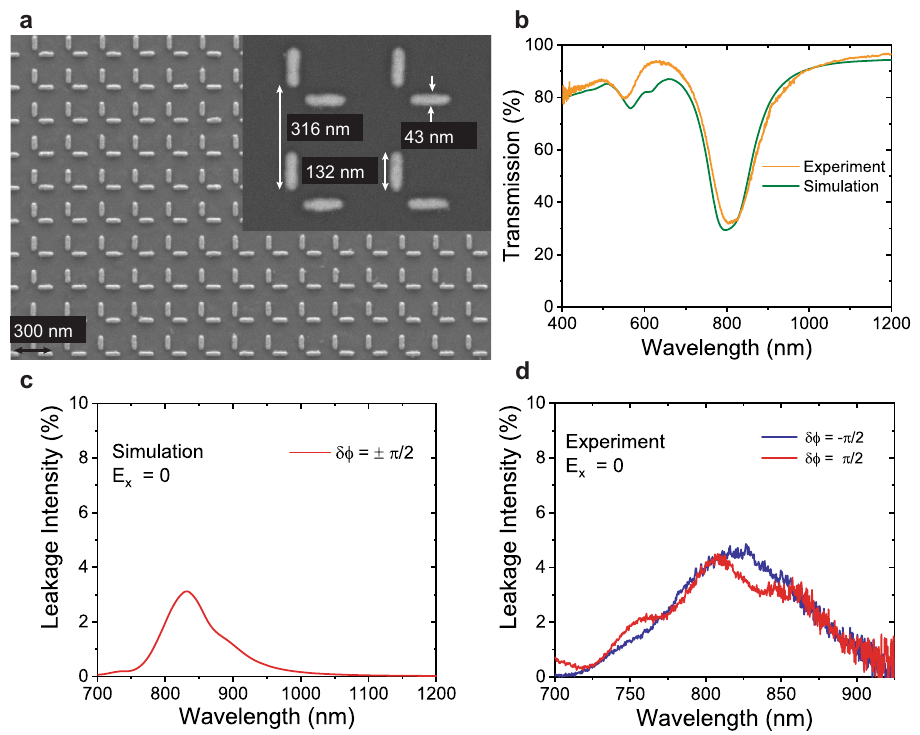
Fig. 2 Metasurface ’ s design realization, spectral response and leakage of the control beam. a SEM image of the fabricated L-shaped metasurface, the inset indicates the nanorod dimensions and period of the metasurface. b Experimental and calculated transmission spectra of the metasurface without any phase delay or polarization control. c , d The fraction of control beam leaking in the output signal intensity, when signal is zero.